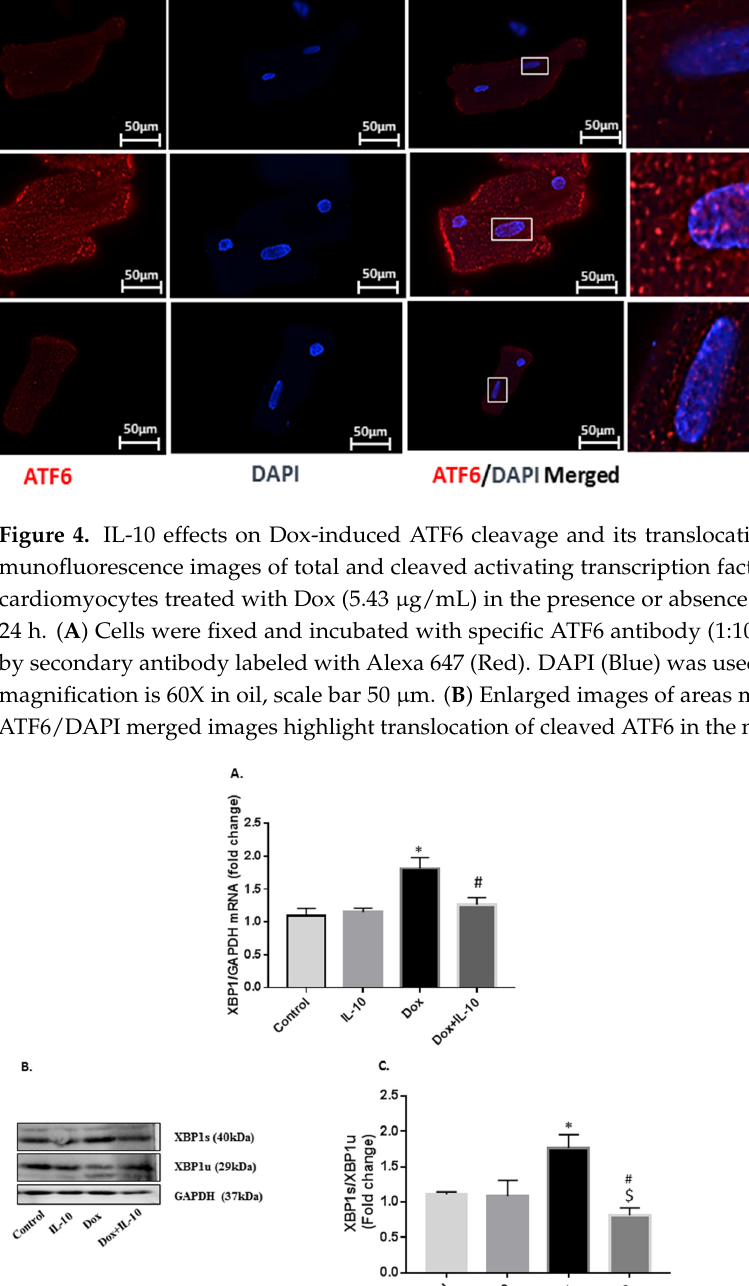
Figure 5. IL-10 effects on Dox-induced changes in XBP1 mRNA and XBP1s/XBP1u protein levels . Expression of X-box binding protein 1 (XBP1) in isolated cardiomyocytes treated with Dox (5.43 µg/mL) in the presence or absence of IL-10 (10 ng/mL) for 24 h. ( A ) Relative expression of mRNA levels of XBP1 using GAPDH as endogenous control. ( B ) Protein levels of spliced XBP1 (XPB1s) and unspliced XBP1 (XBP1u) using XBP1 antibody (1:500). GAPDH is shown as a loading control. ( C ) Densitometric analysis of XBP1s/XBP1u fold change. Data are means +/ − SE from 5 individual experiments. * p < 0.005 vs. control, IL-10; # p < 0.005 vs. Dox; $ p < 0.05 vs. control.